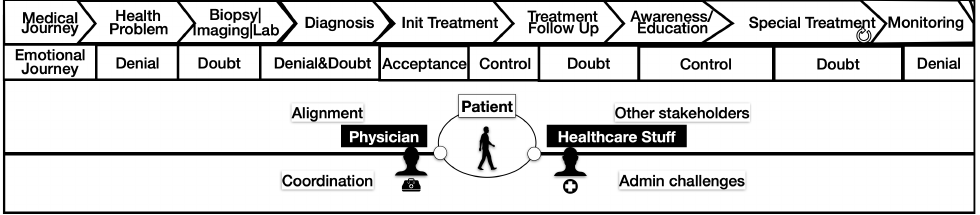
Figure 2. Patient’s